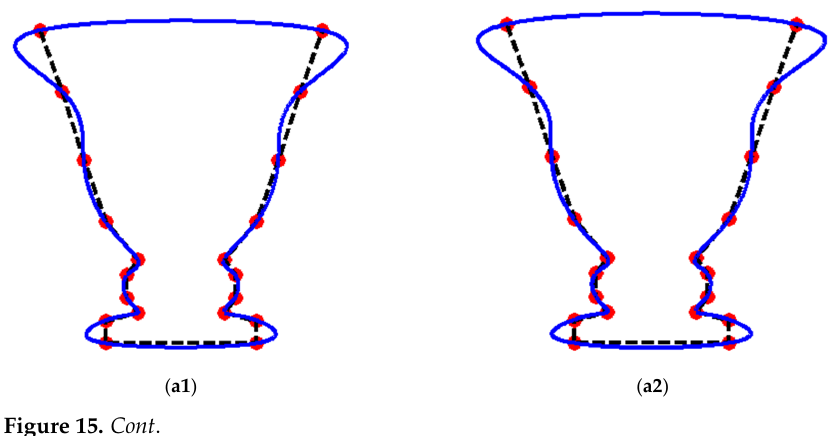
Figure 14. ( a1 ) and ( b1 ) under periodic end conditions, the default RQTS. ( a2 ) and ( b2 ) RQTS